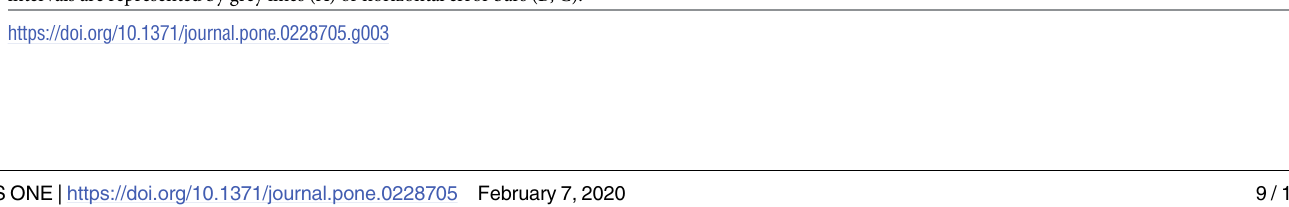
PLOS ONE | https://doi.org/10.1371/journal.pone.0228705 February 7,